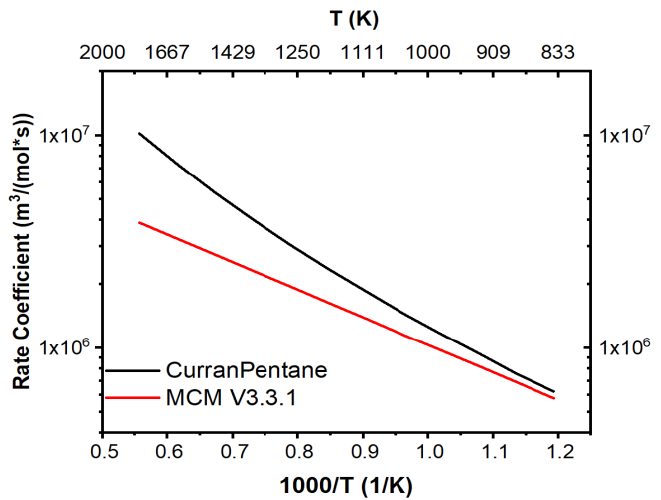
Figure 6. Rate coefficient of C 2 H 4 + OH <=> C 2 H 3 + H 2 O reaction based on the CurranPentane and MCM v3.3.1 MCM v3.3.1 mechanisms.